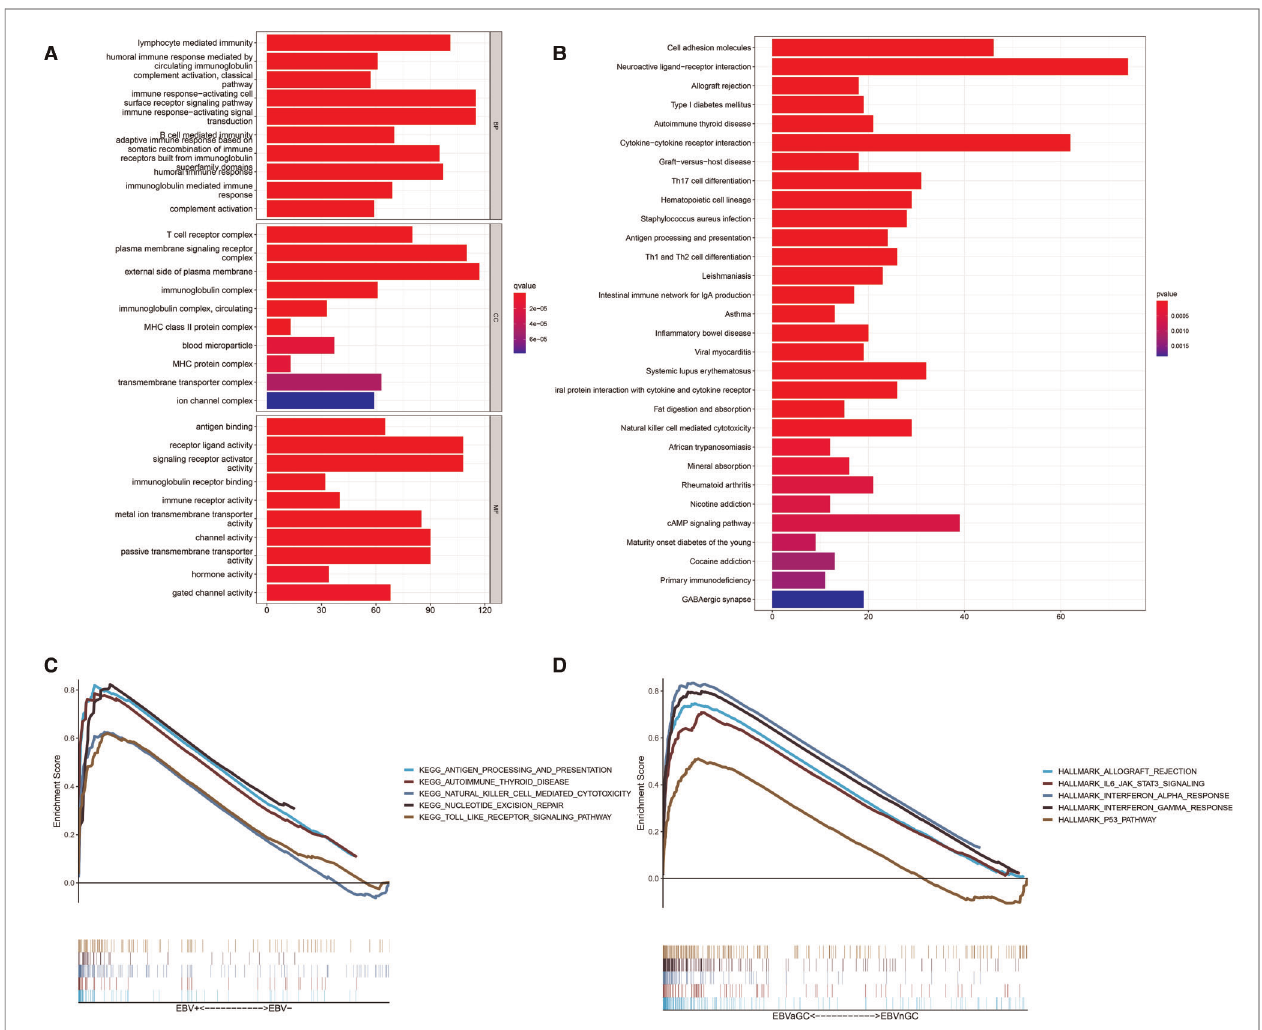
FIGURE 3 | DEGs and functional enrichment analyses. ( A ) GO analysis. ( B ) KEGG pathway analysis. ( C,D ) GSEA for EBVaGC samples. Enriched gene sets in C2 collection, the KEGG gene sets ( C ) and HALLMARK collection ( D